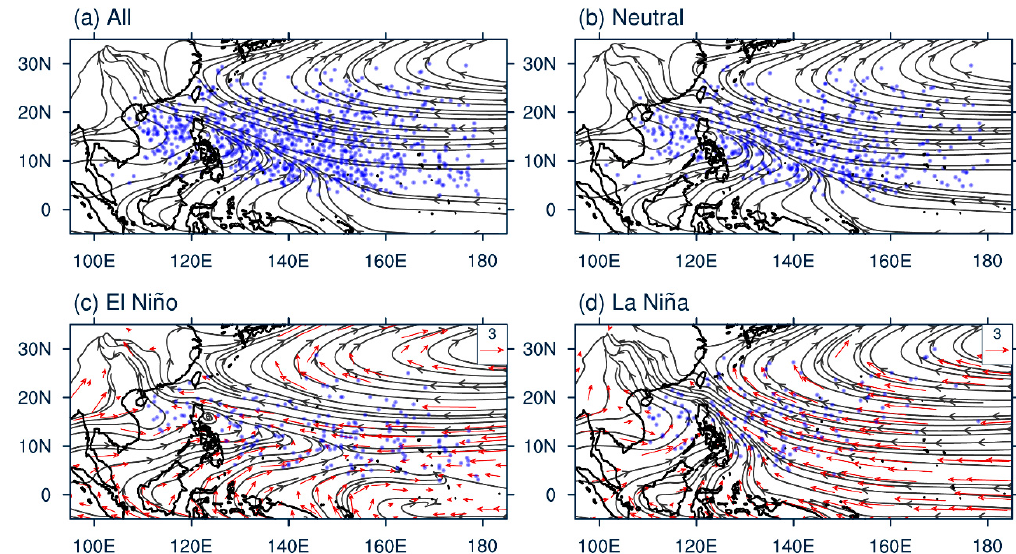
Figure 3. Composites of 850 hPa streamline during the TC season (June–November) for 1979–2016: ( a ) all years, ( b ) neutral years, ( c ) the El Niño years, and ( d ) the La Niña years. TC genesis locations are denoted by filled blue circles. The streamlines show the whole picture of the atmosphere circulation (no statistical significance test was applied), while the wind vectors show the areas where wind anomalies are statistically significant at the 90% confidence level. The unit of the wind vectors is m·s − 1 .